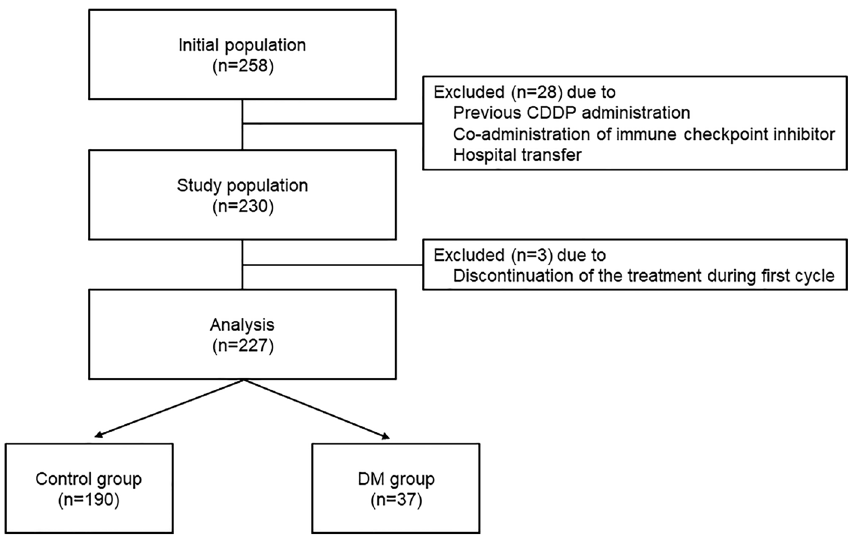
Figure 1. Design of this